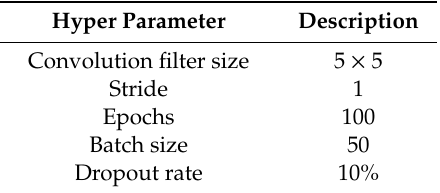
Table 6. Hyper parameters values of CNN.